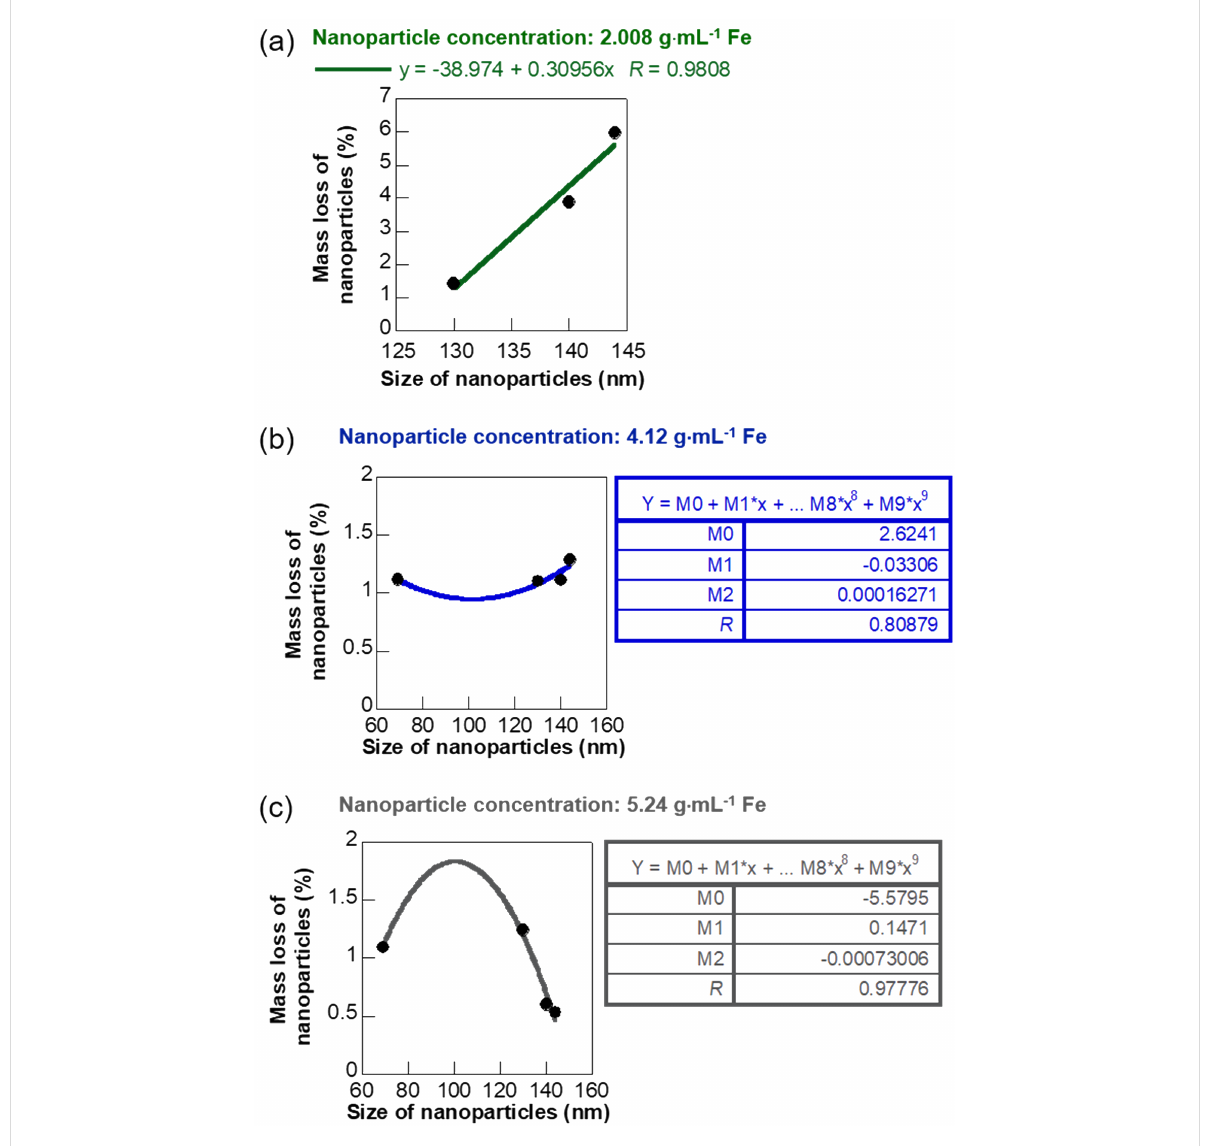
Figure 9: Plot showing the average mass loss percentage of NPs as a function of the size at three different inlet mass concentrations. (a) 2.008 g·mL − 1 Fe, (b) 4.12 g·mL − 1 Fe, and (c) 5.24 g·mL − 1